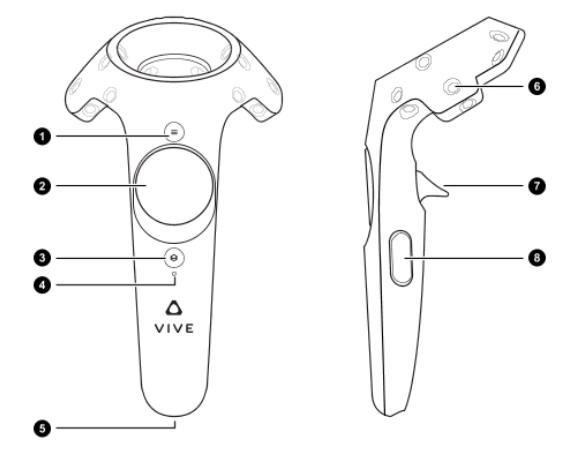
Figure 4. Schematic of HTC VIVE controller. (1) Menu button; (2) Trackpad; (3) System button; (4) Status light; (5) MiroUSB port; (6) Tracking sensor; (7) Trigger; (8) Grip